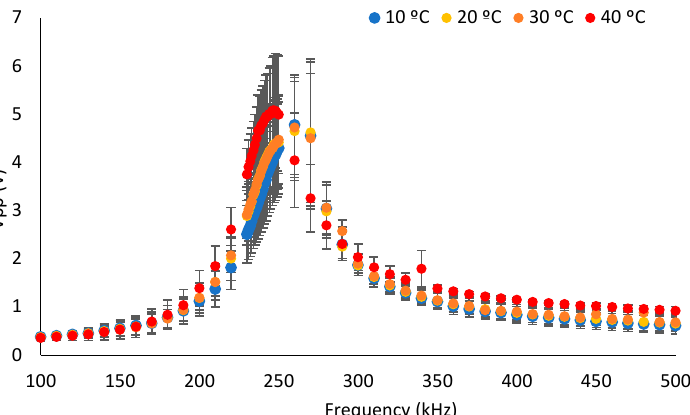
Figure 3. Vpp for different frequencies according to the pH value. Data include the repetitions per- formed for the different temperatures.